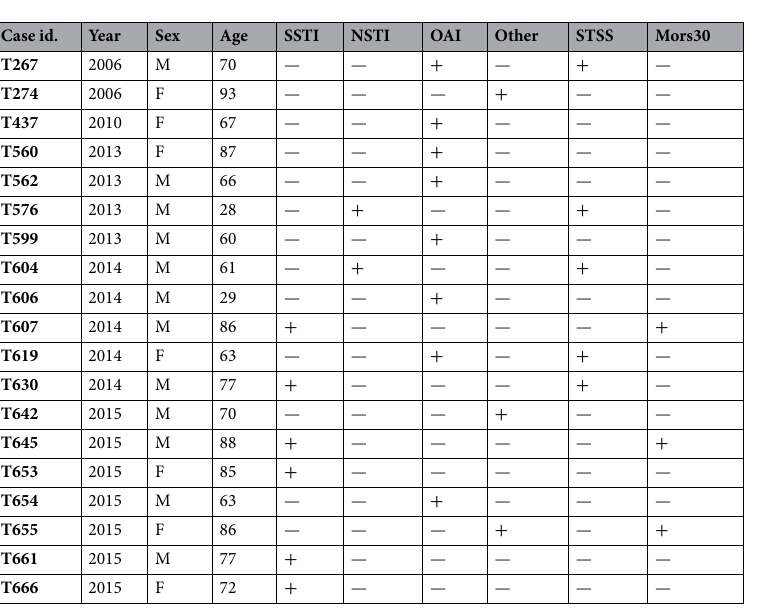
Table 2. Clinical characteristics of the invasive stG6247 -cases. Case id., case identity; SSTI, skin and soft-tissue infection; NSTI, necrotizing soft-tissue infection; OAI, osteoarticular infection; STSS, streptococcal toxic shock syndrome; Mors30, mortality within 30 days of admission; M, male; F, female. Other comprises nosocomial pneumonia (T274), prosthetic valve endocarditis (T642) and primary bacteremia (T655). Symbols + and– denote presence or absence of clinical features,